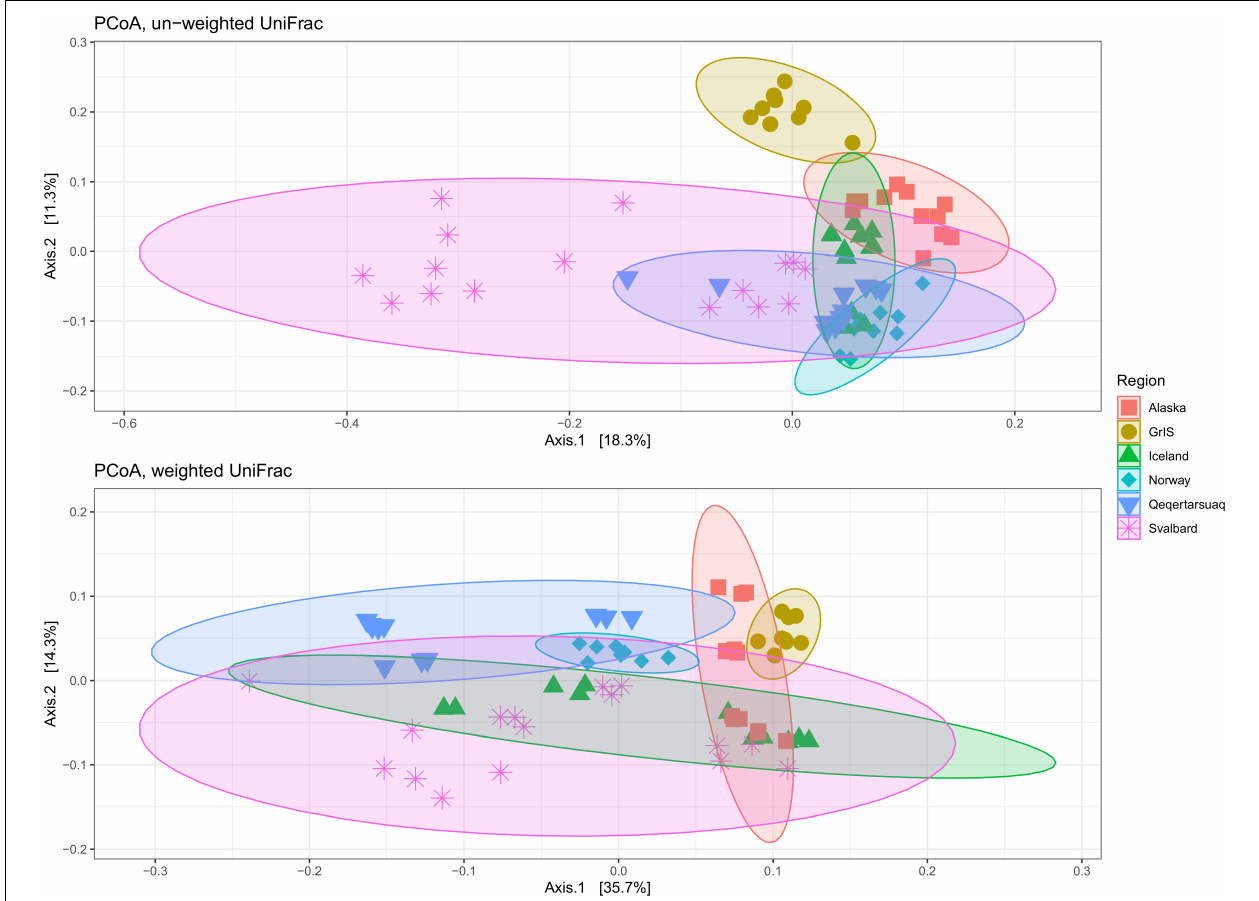
FIGURE 4 | Principle coordinates analysis (PCoA) showing differences between geographic regions on un-weighted (top) and weighted (bottom) UniFrac distances. Alaska sites are shown in red squares, the Greenland Ice Sheet (GrIS) in gold circles, Iceland in green triangles, Norway in turquoise diamonds, Qeqertarsuaq in blue upside-down triangles, and Svalbard in purple asterisks. Colored circles indicate 95% confidence intervals of regional categories.